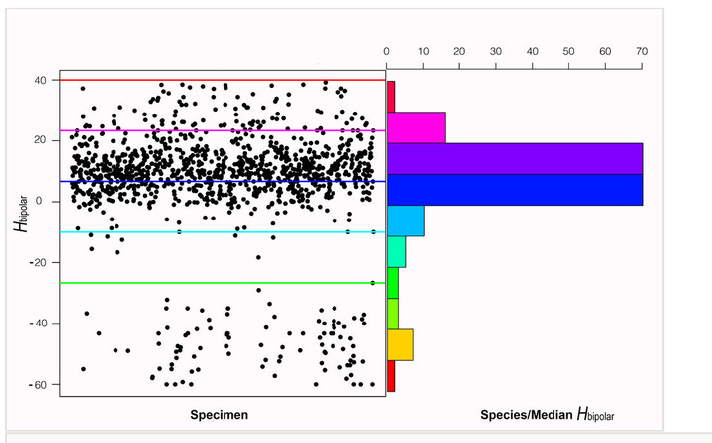
Figure 7. Distribution of hue values returned from "blue flowers" during EOL